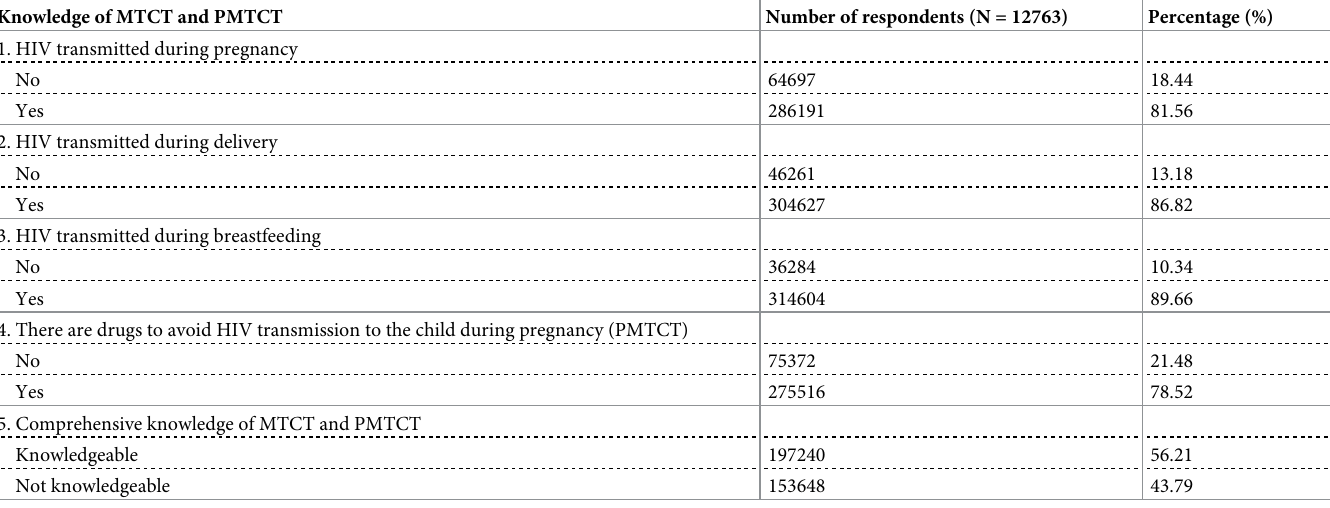
Table 2. Knowledge about MTCT of HIV/AIDS and its prevention among reproductive-age women in SSA. Knowledge of MTCT and